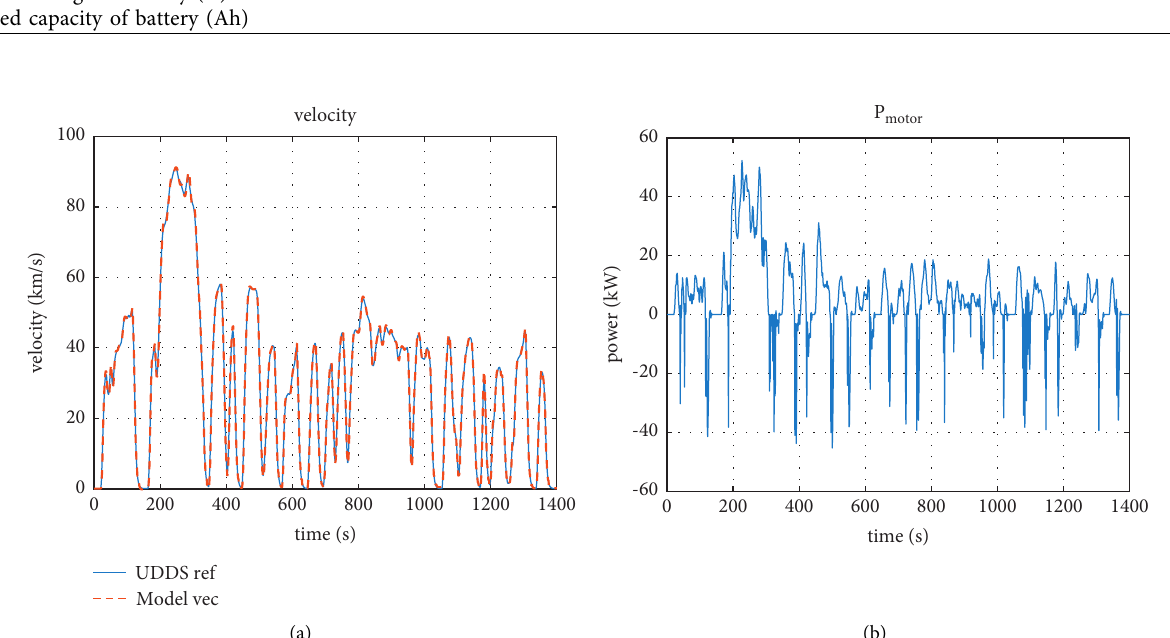
Figure 17: Simulation result of velocity and output power of motors. (a) Velocity tracking. (b) Output power of distributed drive